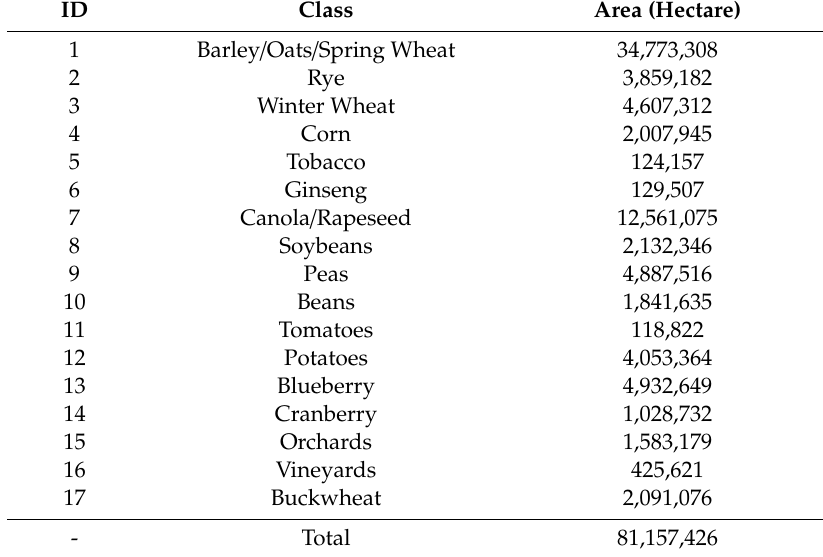
Table 3. Area of di ff erent cropland classes over the study area calculated from the produced ACI map in this